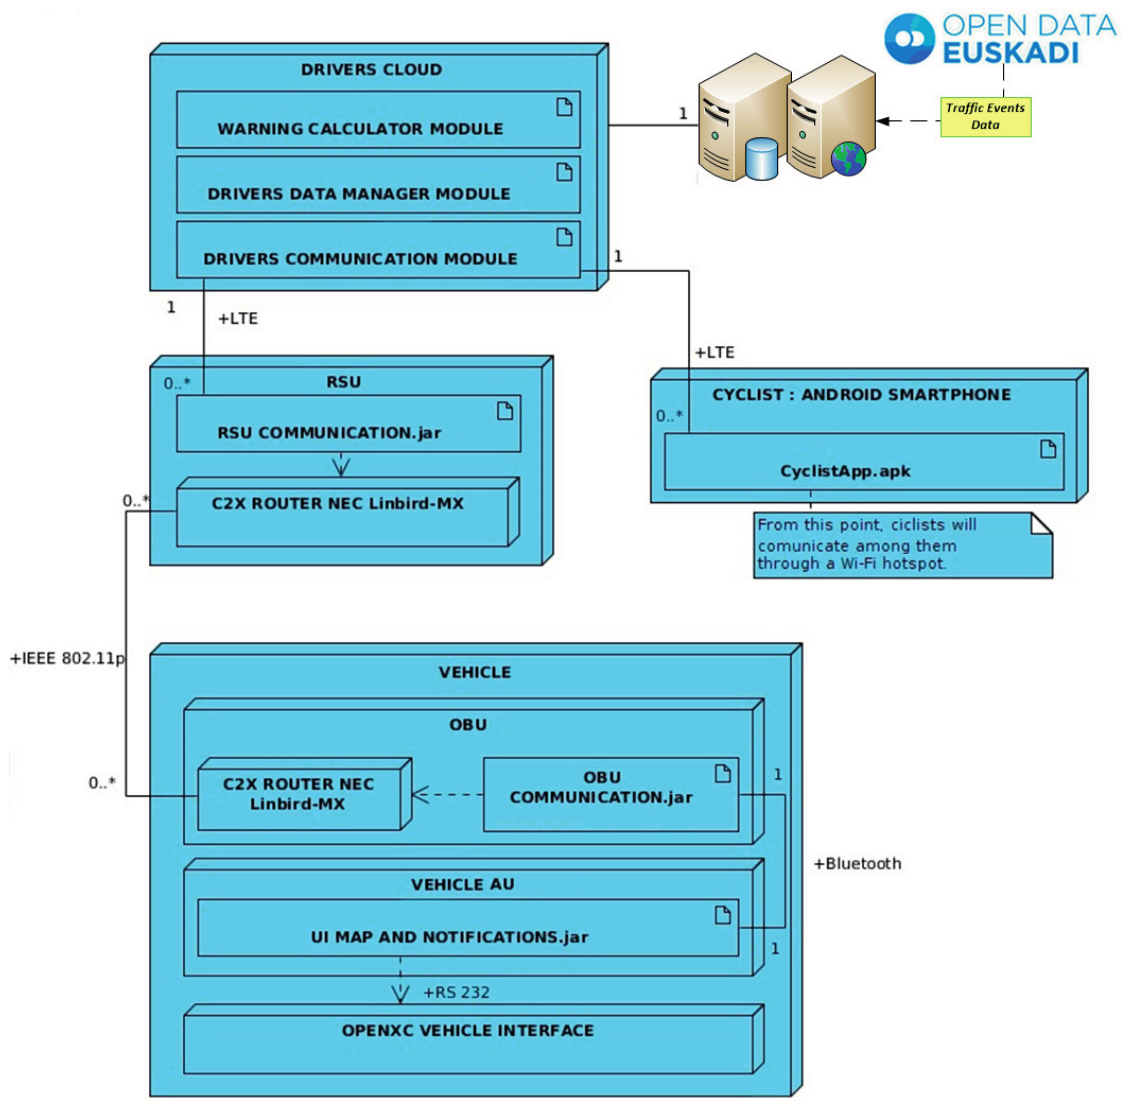
Figure 6. V-Alert software